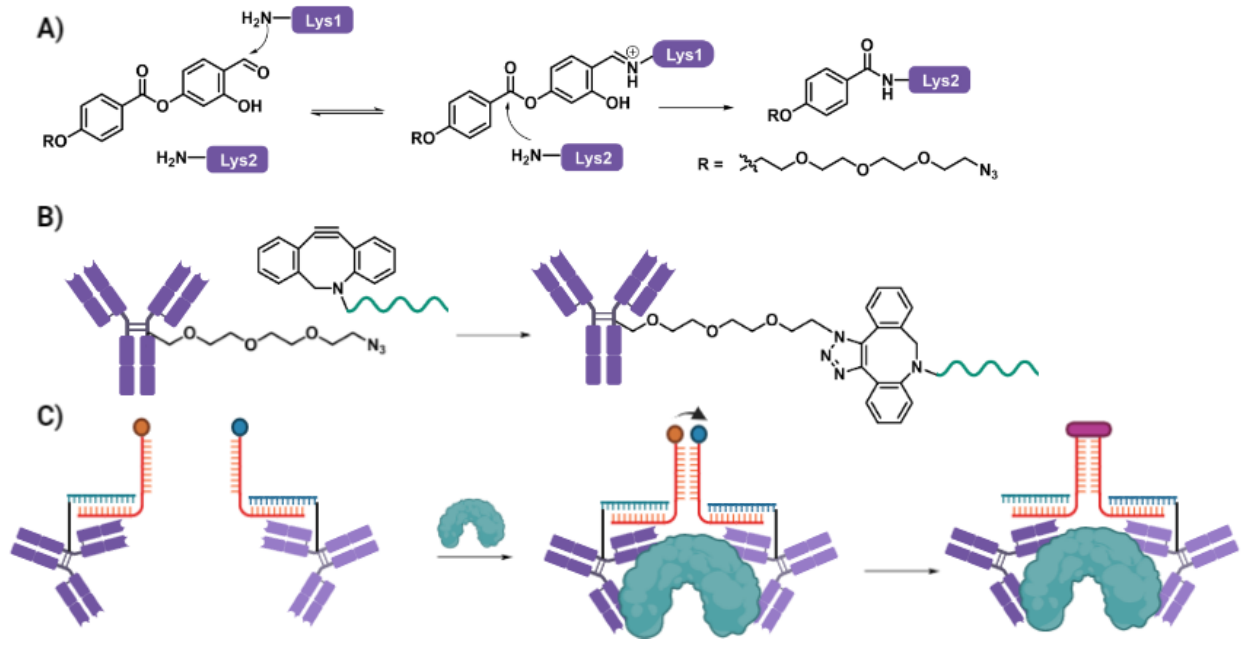
Figure 4. Case Study 1: lysine directed labelling of IgG1 for templated reactivity. ( A ) Initial iminium ion formation activates the p-phenyl ester towards attack from a second nearby lysine residue, enabling site specific conjugation to the hinge region of IgG1 antibodies ( B ). This can be exploited for proximity templated chemistry through the use of an orthogonal pair of antibodies against a single target ( C ).